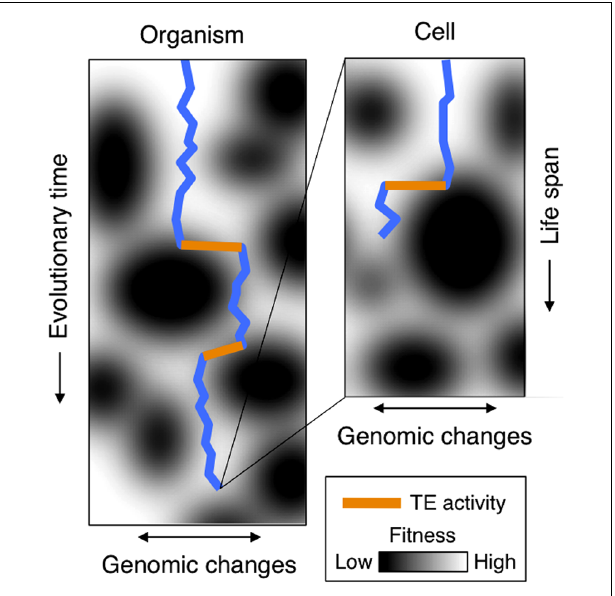
FIGURE 1 | Left: the trajectory of an organism through a fitness landscape (blue line). As time passes (vertical movement), genomic changes (horizontal movements) are accumulated.When encountering regions of lower fitness (dark areas), e.g., caused by chancing environments,TE may induce substantial genomic changes as indicated by orange lines. Right: the evolution within an individual cell’s life span.When encountering stress (dark areas), activation ofTE induces genomic changes, which in turn may lead to cancer